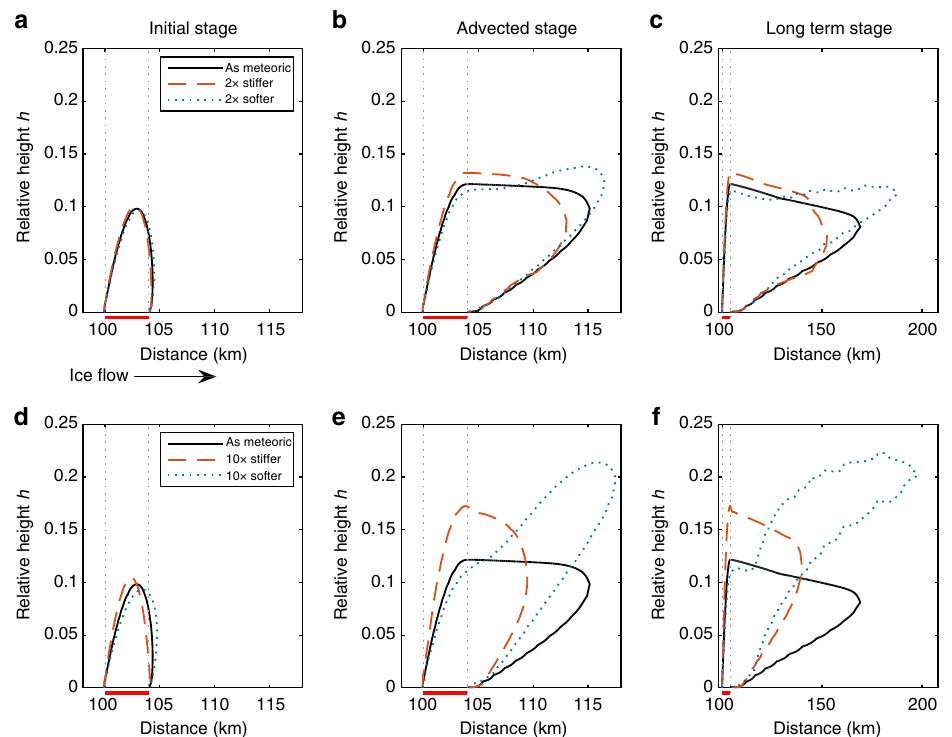
Fig. 8 Plume-height dependency on rheology contrast between accreted and meteoric ice. Modelled interface between accreted and meteoric ice using the FS model (Elmer/Ice 38 ) as used in Fig. 4, but now with modi fi ed accreted ice viscosity. Comparison between stiffer (red dashed line) and softer (blue dotted line) ice with ice of uniform viscosity (black solid line). a – c Twofold (2×) viscosity contrast between accreted and meteoric ice. d – f Tenfold (10×) viscosity contrast between accreted and meteoric ice. The snapshots in time show the different growth and advection stages: a , d vertical plume growth for all three cases; b , e only horizontal advection, except for the soft case, which is still growing; c , f only horizontal advection for all cases. All three time snapshots show accretion area (red horizontal bar) and margin (light-grey dotted line). Note different horizontal scale for c ,